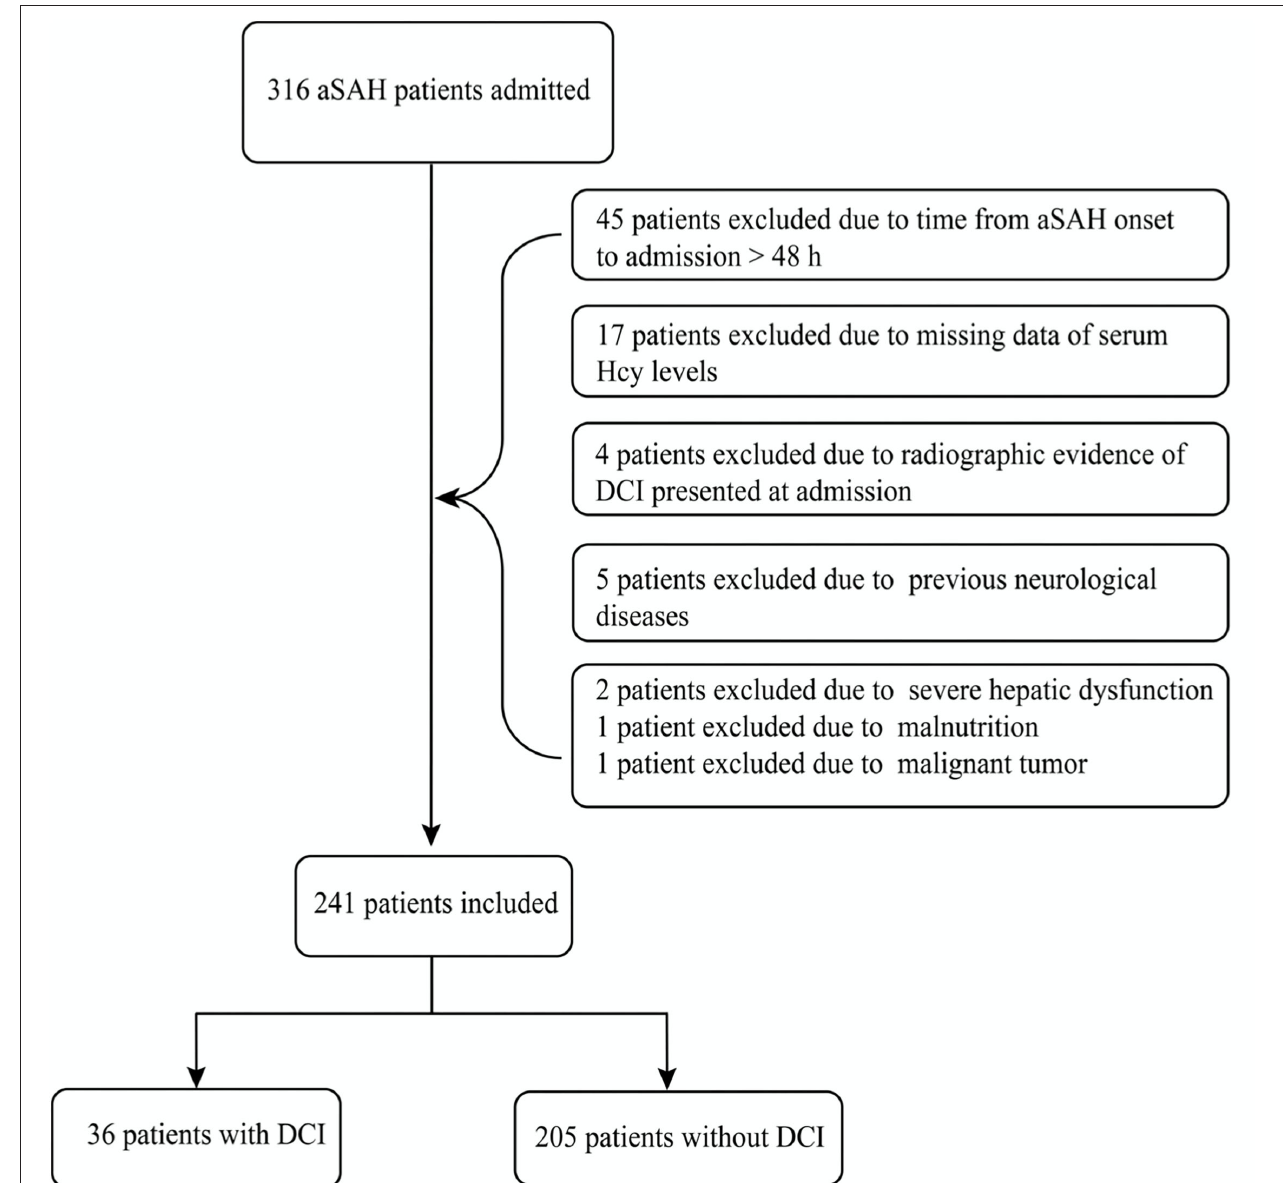
FIGURE 1 | Flowchart of our study. A total of 241 patients with aneurysmal subarachnoid hemorrhage (aSAH) were finally included in this study, meanwhile, 36 patients suffered from delayed cerebral ischemia (DCI) days later.